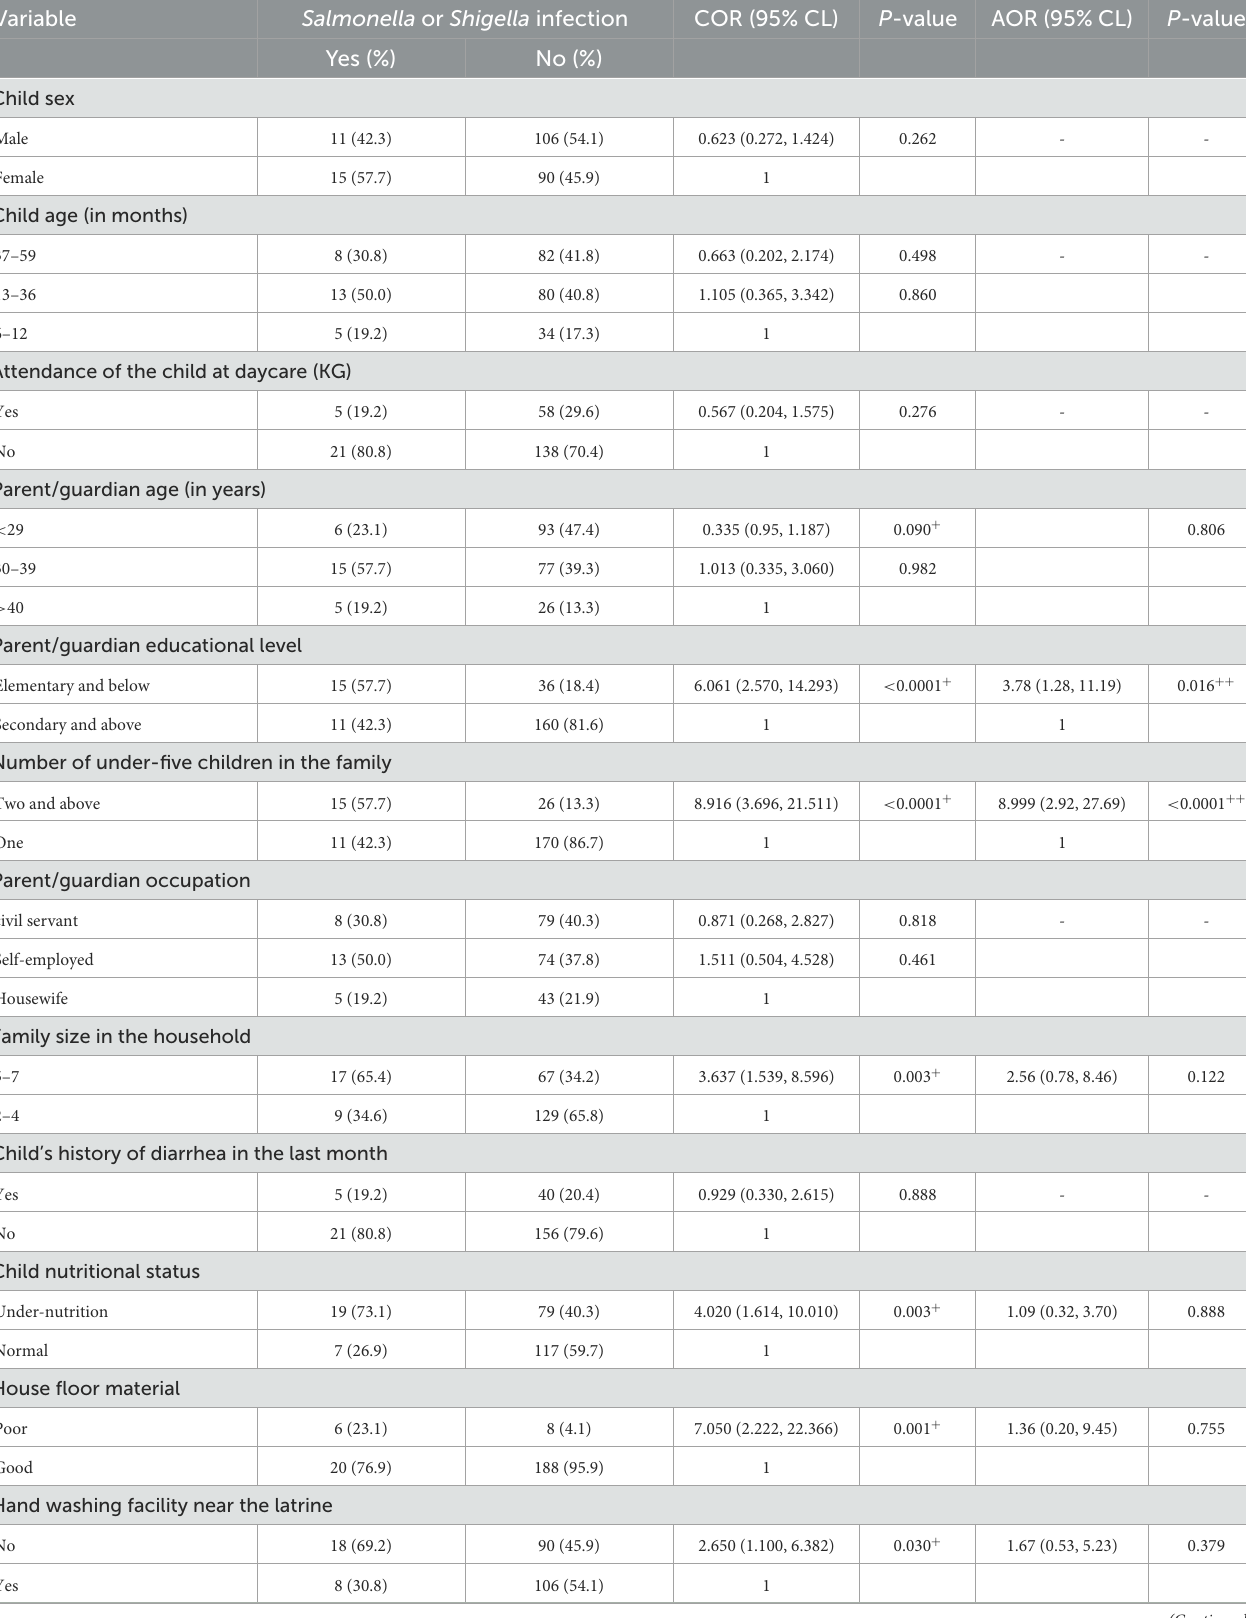
TABLE 6 Bivariable and multivariable logistic regression analysis of factors associated with Salmonella and Shigella infection among under-five children at public health facilities in Debre Markos town, 2022.